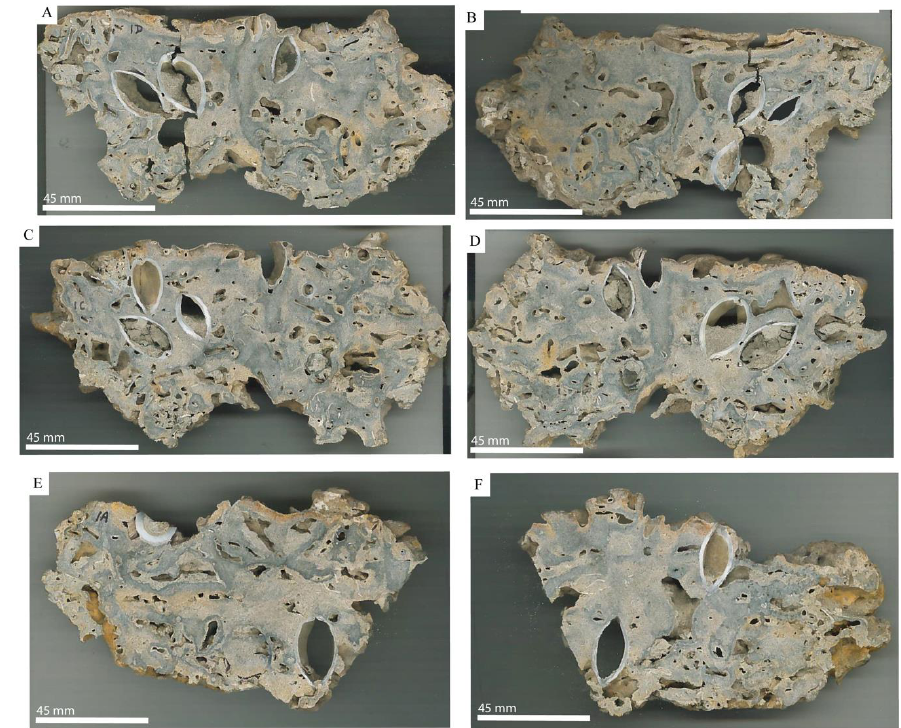
Figure 2. ( A – F ) Optical photographs of sawn slabs of methane-derived authigenic cement (MDAC) pavement, from the current study. Illustrating the occurrence of bivalves, boring and the patchy development of cement. development of cement. Geosciences 2020 , 10 , x FOR PEER REVIEW